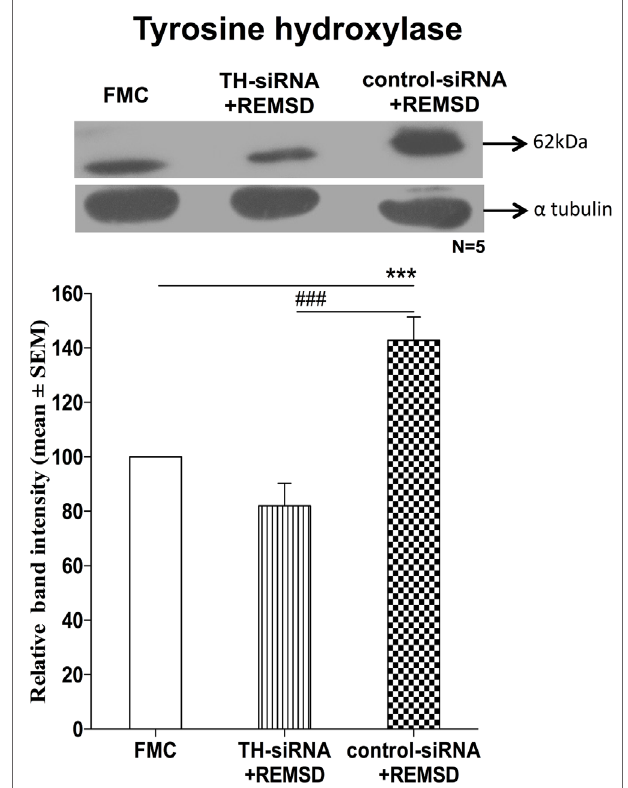
FigUre 10 | expressions of Th in homogenate of reMsD rat brains after microinjection of Th-sirna or control sirna bilaterally into lc . Upper panel shows a representative Western blot of tyrosine hydroxylase. Histogram in the lower panel shows percent changes in the mean ( ± SEM) band densities of the blots as compared to FMC (without injection) taken as 100% in five sets of experiments. Abbreviations are as in the text. Significance levels are between the treatments of connecting horizontal bars; *** p < 0.001 and ### p < 0.001, * as compared to FMC and # as compared to TH-siRNA + REMSD.